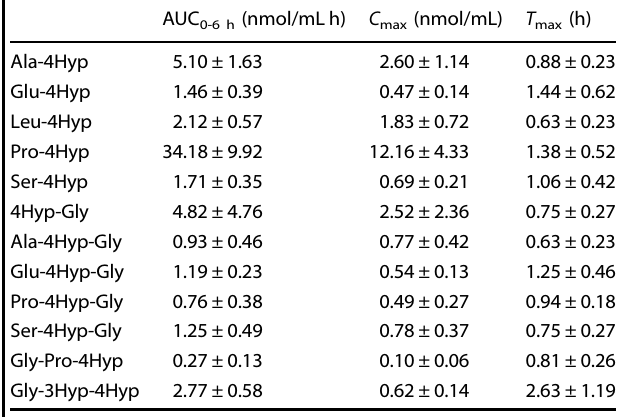
Table 1. AUC 0-6 h , C max , and T max of Hyp-containing oligopeptides in human plasma after oral ingestion of collagen